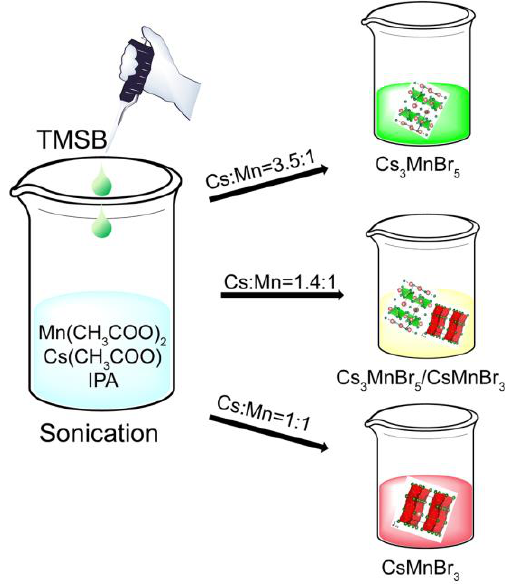
Figure 1. Schematic illustration of the synthetic procedure for Cs 3 MnBr 5 and CsMnBr 3 using a room-temperature sonication crystallization